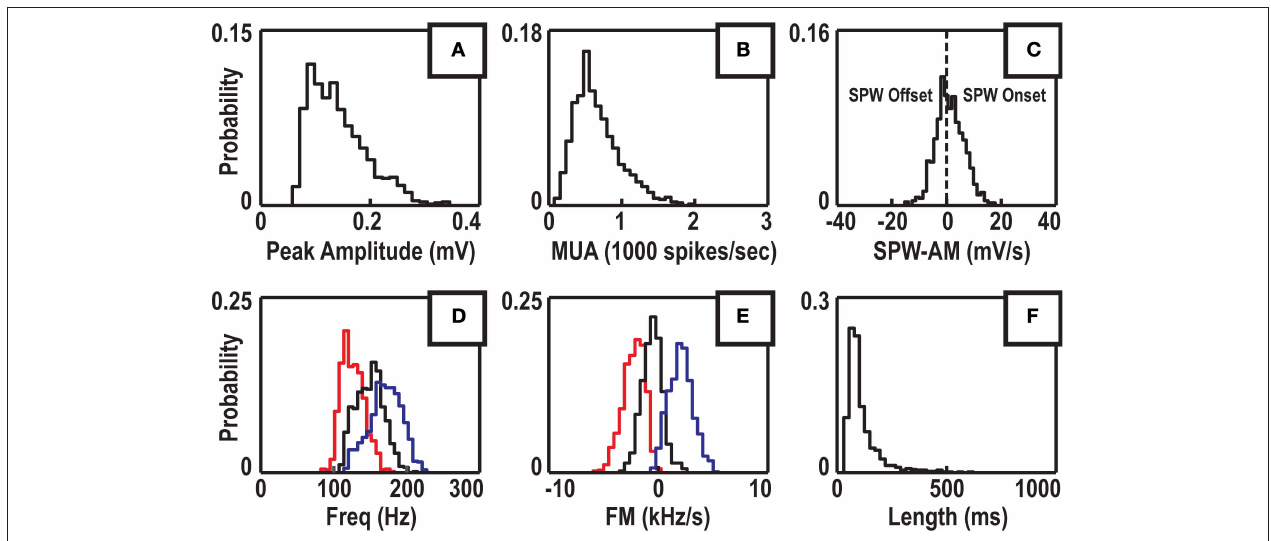
FIGURE 3 | Probability distribution of ripple features for Rat 1. (A) Maximum of the ripple amplitude envelope. (B) Maximum value of multi- unit rate within ripple. (C) Amplitude modulation of sharp wave signal (1–25 Hz) measured around the time of the ripple peak. (D) Max., mean, and min.